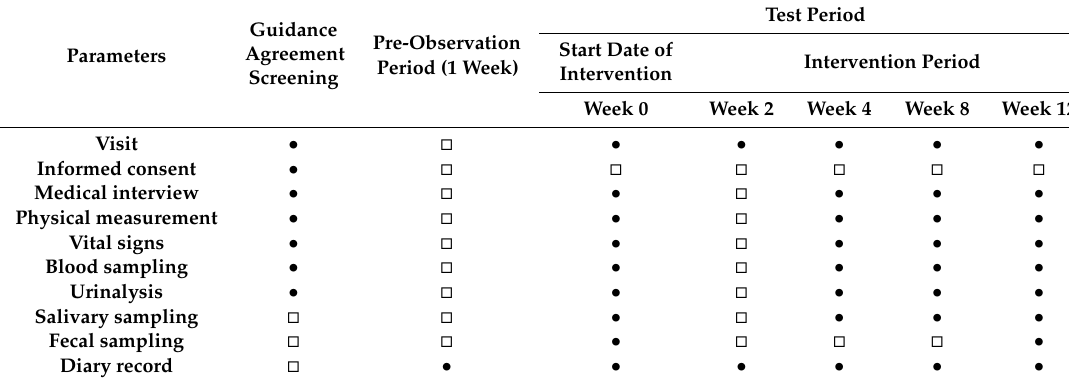
Table 1. Clinical trial